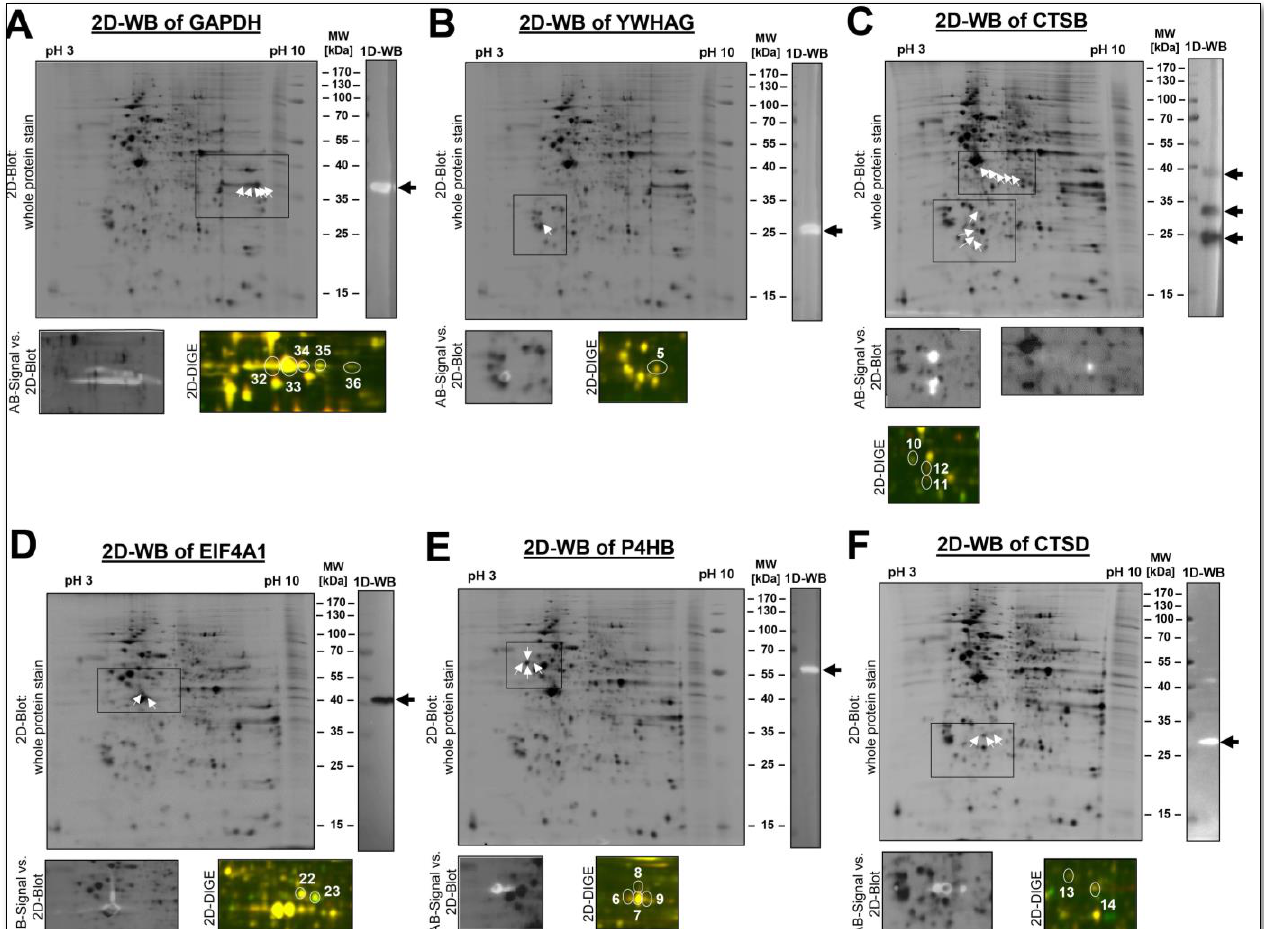
Figure 8. 2D- and 1D-WB validation of selected proteins and proteoforms mutually identified by 2D-DIGE. 30 µg of Cy5-labeled DU145 protein was applied to IEF on a 7 cm pH 3 – 10 IPG-strip followed by 11.5% SDS-PAGE and blotted onto a PVDF membrane. These blotted Cy5 labeled proteins on the PVDF membranes were scanned with a laser scanner at 650 nm wavelength and shown as black spots. 2D-WB image (left large images) of DU145 sample. The PVDF membrane of the blotted Cy5-stained DU145 protein sample is stained with antibodies against ( A ) GAPDH, ( B ) YWHAG, ( C ) CTSB, ( D ) ElF4A1 ( E ) P4HB and ( F ) CTSD and the specific signals are visualised by secondary HRP-conjugated antibodies and chemiluminescence (white spots). Overlay of Cy5-labelled 2D-WB spot signals (black spots) vs. antibody-specific 2D-WB signals (white spots). One-dimensional WB shows the particular antibody signal (white band) as the sum in a single band (right image). The 2D-DIGE image shows the positions of different proteoforms (bottom), and the circled spots with a number match those listed in Table 1. The results of shotgun analysis from these proteins are shown in Supplementary Table S3. Abbreviations: 2D-DIGE—two-dimensional difference gel electrophoresis; MW—molecular weight; IEF—isoelectric focusing; IPG—immobilised pH gradient; WB—western